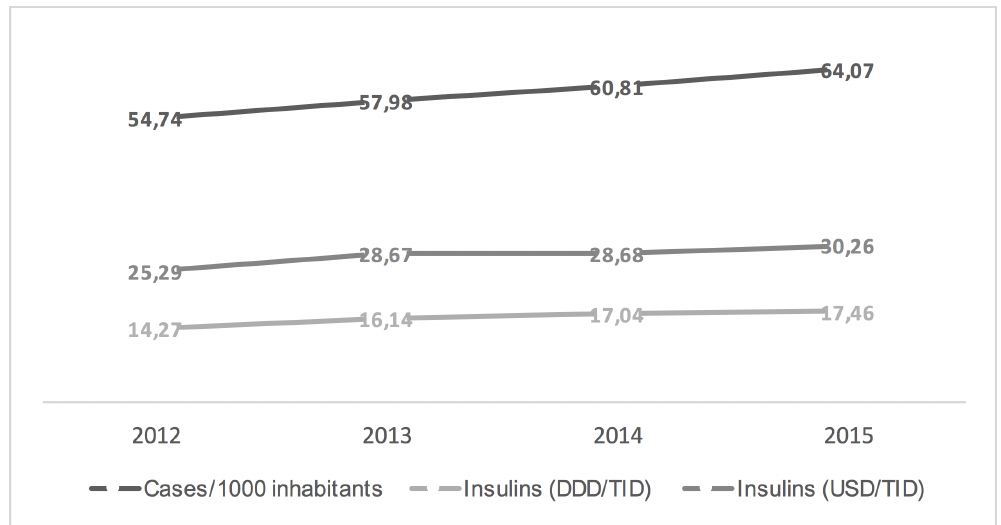
Fig 2. Trends in the diabetes mellitus morbidity (casesper 1000inhabitants), insulin consumption (DDD/ TID) and costs (USD/TID) in Poland, 2012–2015.